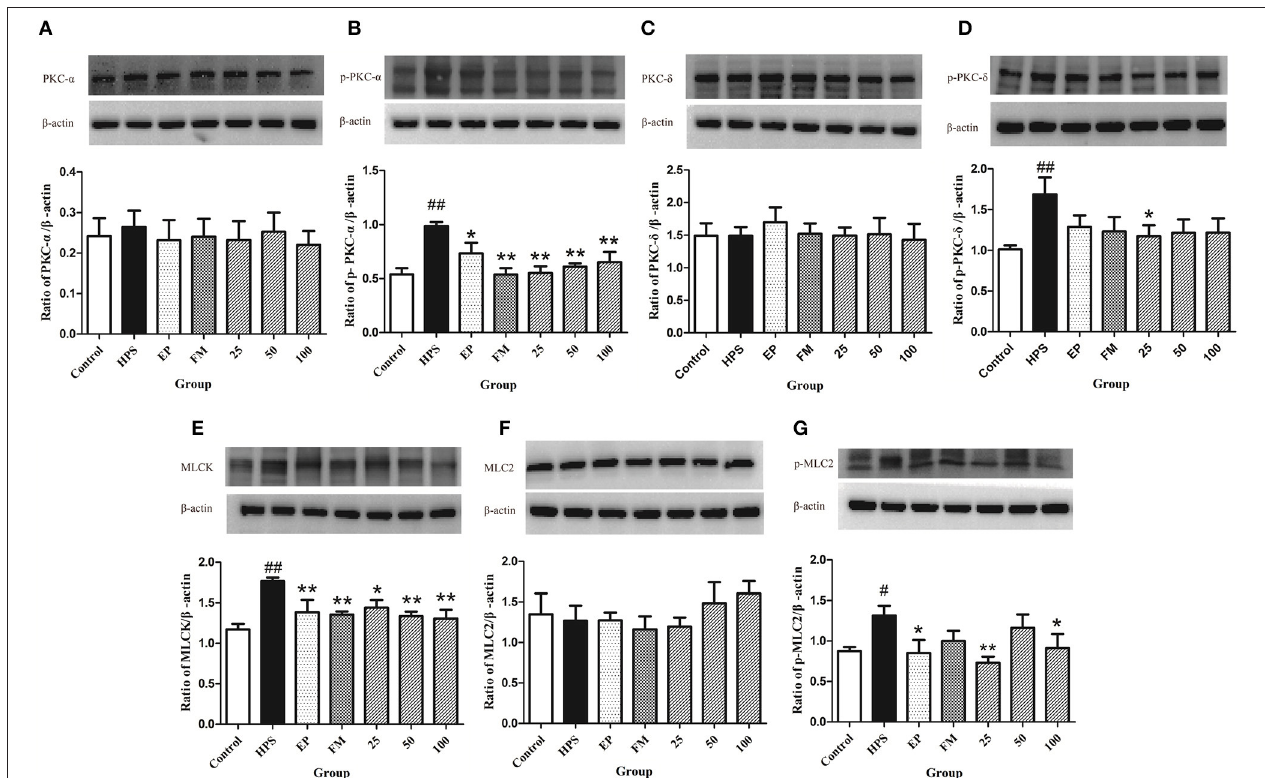
FIGURE 4 | Effects of baicalin on PKC and MLCK/MLC pathways in aorta activated by G. parasuis PKC- α (A) , p-PKC- α (B) , PKC- δ (C) , p-PKC- δ (D) , MLCK (E) , MLC-2 (F) , and p-MLC-2 (G) (mean ± SD, n = 3). HPS: G. parasuis group, EP: EP + G. parasuis group, FM: FM + G. parasuis group, 25: 25 mg/kg baicalin +